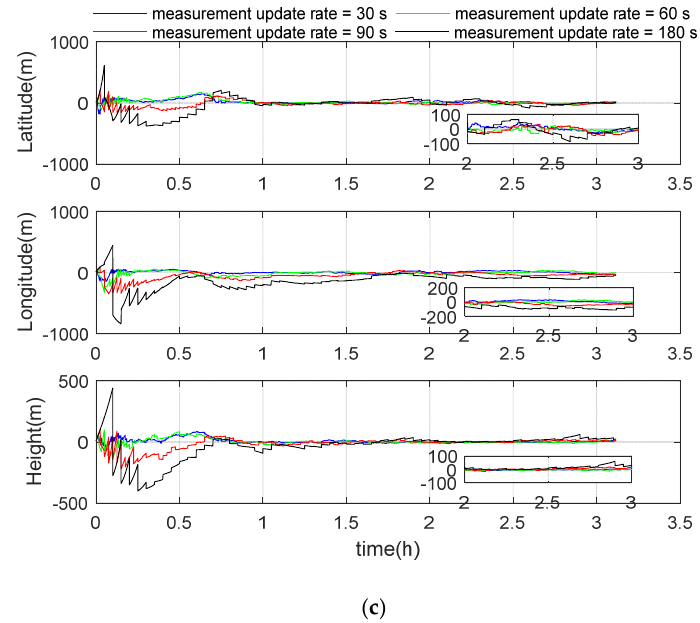
Figure 4. ( a ) Attitude error curve; ( b ) velocity error curve; ( c ) position error curve. Table 3. Simulation results under different measurement update periods.